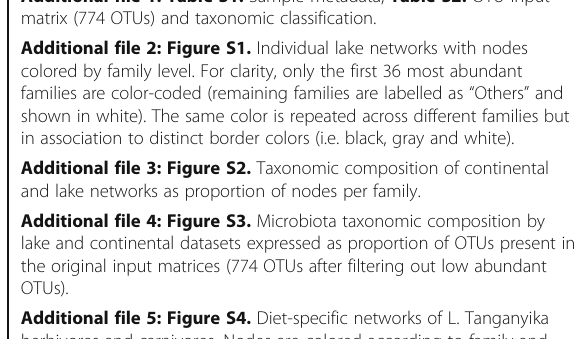
Additional file 2: Figure S1. Individual lake networks with nodes colored by family level. For clarity, only the first 36 most abundant families are color-coded (remaining families are labelled as “ Others ” and shown in white). The same color is repeated across different families but in association to distinct border colors (i.e. black, gray and white). Additional file 3: Figure S2. Taxonomic composition of continental and lake networks as proportion of nodes per family. Additional file 4: Figure S3. Microbiota taxonomic composition by lake and continental datasets expressed as proportion of OTUs present in the original input matrices (774 OTUs after filtering out low abundant OTUs). Additional file 5: Figure S4. Diet-specific networks of L. Tanganyika herbivores and carnivores. Nodes are colored according to family and sized by betweenness values normalized by lake. Grey shades represent distinct modules (connected by red